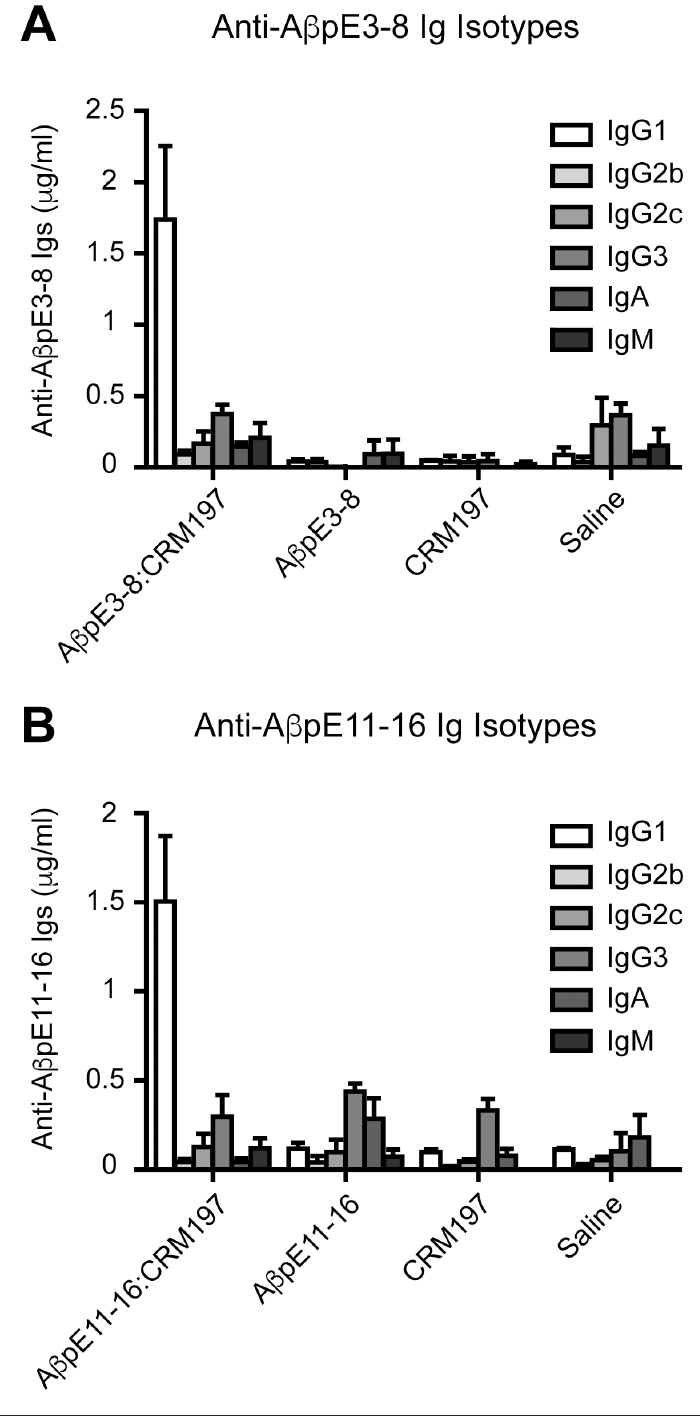
Figure 3. Isotype specificity of the Ig response elicited by A β pE3-8:CRM197 and A β pE11- 16:CRM197 vaccines. (A) Anti-A β pE3-8 and (B) anti-A β pE11-16 Ig isotype (IgG1, IgG2b, IgG2c, IgG3, IgA and IgM) concentrations in sera obtained from mice immunized with A β pE3-8 or A β pE11-16 conjugated (A β pE3-8:CRM197, A β pE11-16:CRM197) or not (A β pE3-8, A β pE11-16) with CRM197. Data represents mean ± standard error of the mean from three to seven mice per